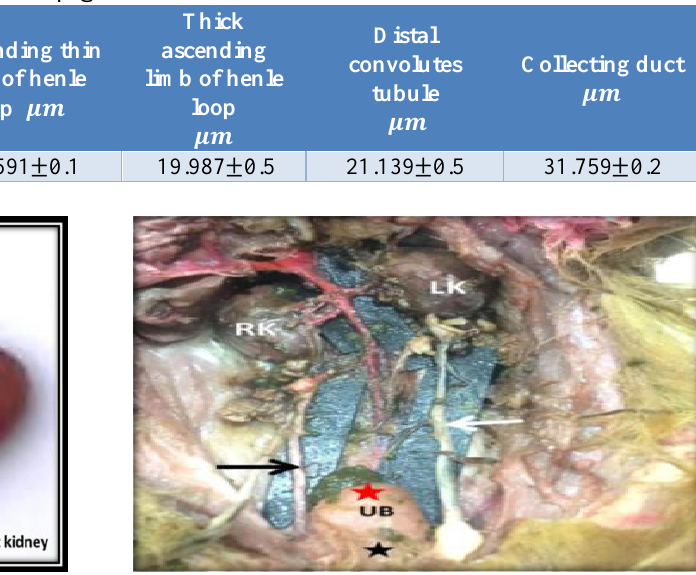
Figure, 3: photograph shows the right kidney (RK) and left kidney (LK) of male guinea pig. Note the left ureter (white arrows) and right ureter (black arrow), bladder (red star).